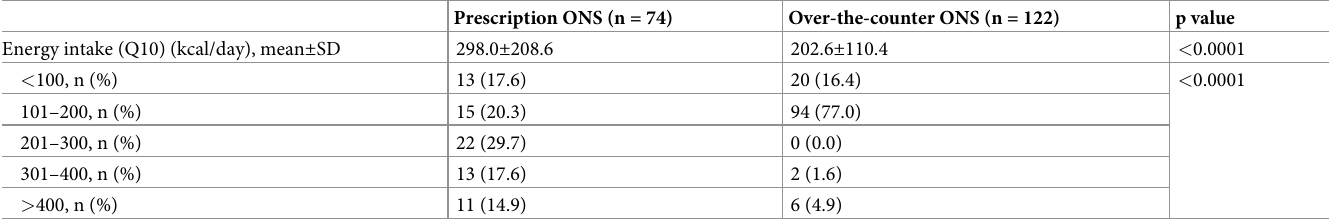
Table 8. Energy intake.